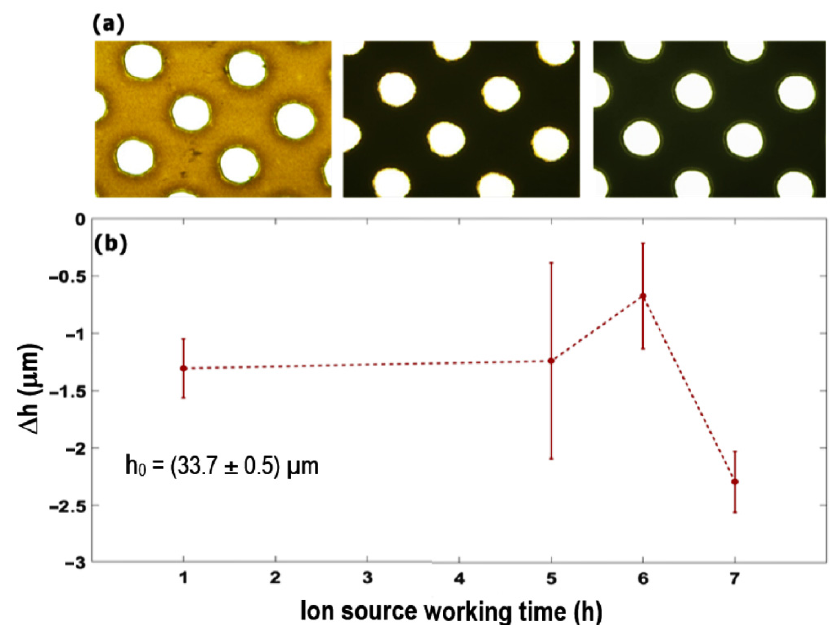
Figure 5. ( a ) Left-to-right: bright-field optical microscopy images showing the progressive pyrolysis of SU8 photoresist mask patterned with arrays of 200 μ m diameter circles after DS sputtering at low sputtering rate (V b = 600 V and I b = 30 mA) and a total working time of 1, 5, and 7 h. Apart from pyrolysis, no evident cracks or damage signs were visible. ( b ) Time evolution of the double layer depth (silicon + SU8) measured inside the photoresist-free areas, relative to “pre-sputtering” depth h 0 (i.e., starting photoresist mask thickness). Negative values of Δ h translate into a sputtering rate ratio of SU8-to-silicon bigger than unity, in contrast with simulation results. A nonlinear behavior was observed.